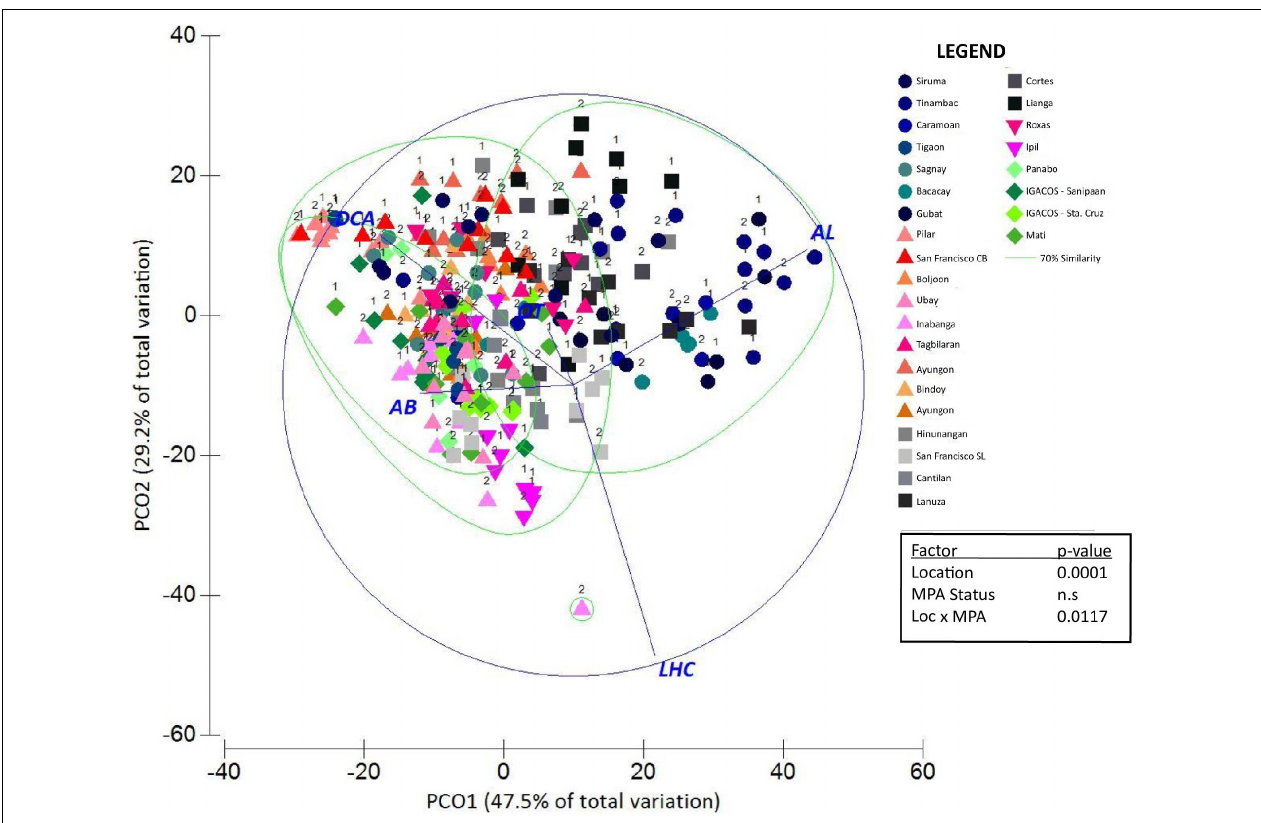
FIGURE 4 | PCO Plot showing the distances between the locations according to differences in the multivariate benthic cover, with vectors depicting Spearman correlation with the different benthic groups. 1, inside MPA; 2, outside